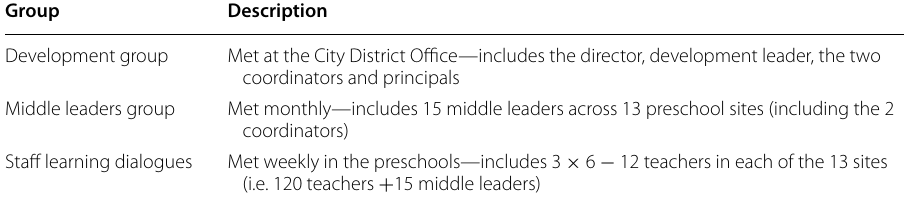
Table 1 The structure of the Systematic Quality Development Project in the city district